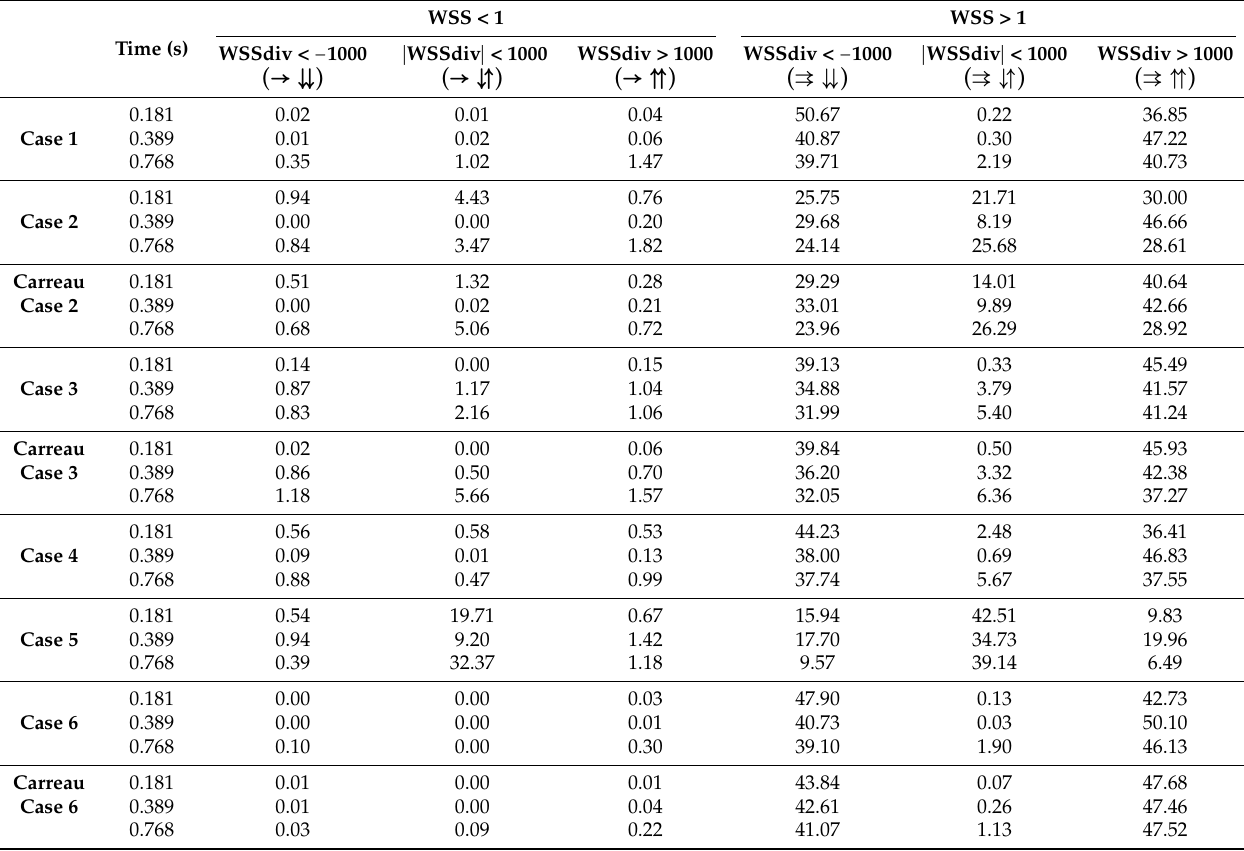
Table 3. Percentage area of aneurysm which satisfies conditions on WSS and WSSdiv. WSS < 1 suggests slow tangential flow ( → ), WSS > 1 suggests faster tangential flow ( ⇉ ), WSSdiv < − 1000 suggests fast perpendicular flow to the wall ( ⇊ ), WSSdiv > 1000 suggests fast perpendicular flow from the wall ( ⇈ ), ∣ WSSdiv ∣ < 1000 suggests slow flow perpendicular to the wall ( (cid:157) ). The partitioning of the area is based on the underlying discrete surface mesh, the vertices of which hold the function values. If any vertex of a mesh element did not satisfy the partitioning criteria, it was not included. Consequently the sum of the areas in the rows does not add to 100%, as we have in effect also excluded partial perimeters to the partitioned regions. This does not affect the analysis. Units: WSSdiv (Pa m − 1 ), WSS (Pa). Results are presented to two decimal